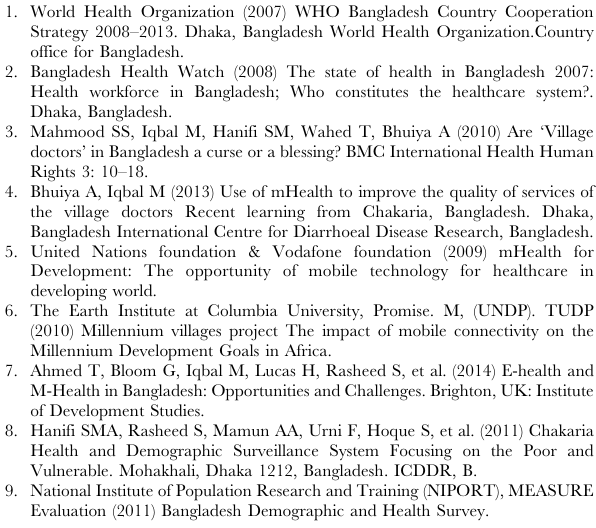
Reasons for calling a doctor for future sickness with mobile phones